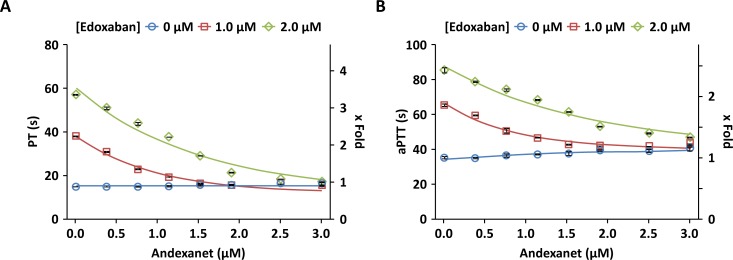
In vitro reversal of edoxaban-induced prolongation of PT and aPTT in human plasma.Plasma samples contained edoxaban at 0 (○), 1.0 (□), and 2.0 μM (◇) and increasing concentrations of andexanet (0, 0.38, 0.76, 1.14, 1.52, 1.9, 2.5, and 3.0 μM). PT and aPTT were measured on Stago Compact as described in Materials and Methods. Data were plotted as the mean ± standard deviation from two separate experiments.